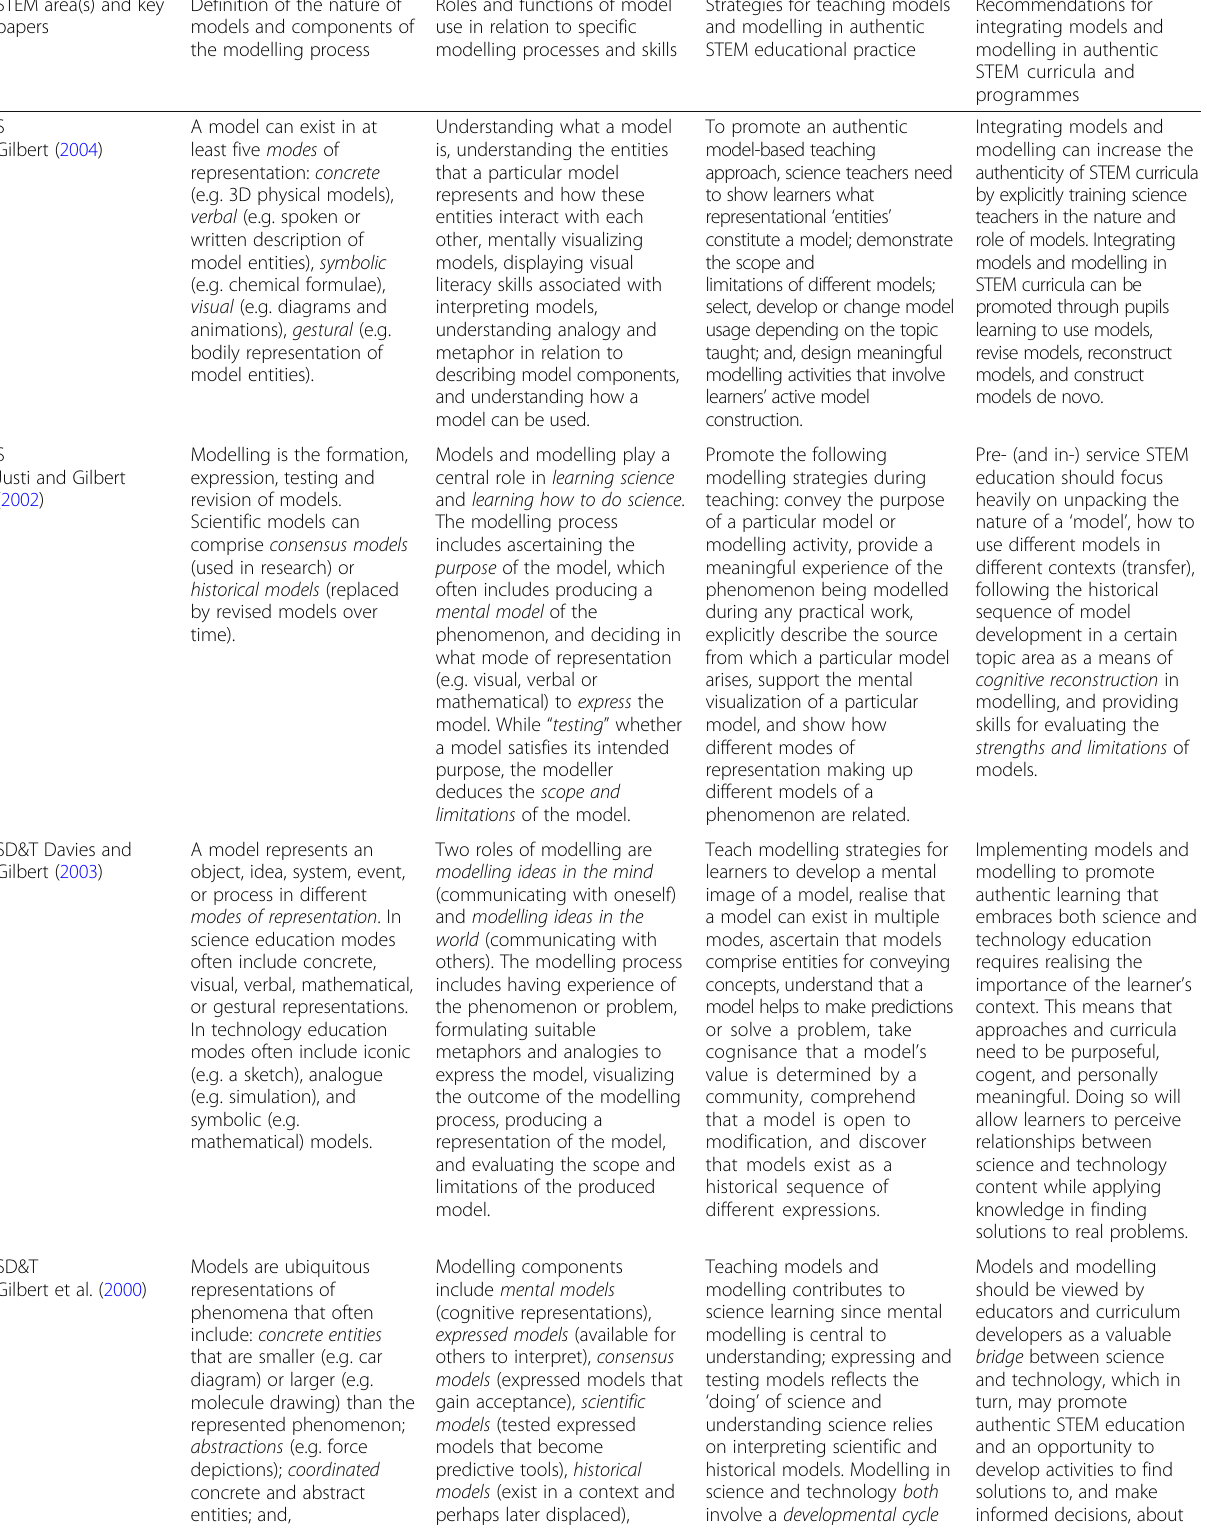
Table 1 Roles, functions, strategies and recommendations for using models and modelling in pursuit of authentic STEM education and literacy STEM area(s) and key